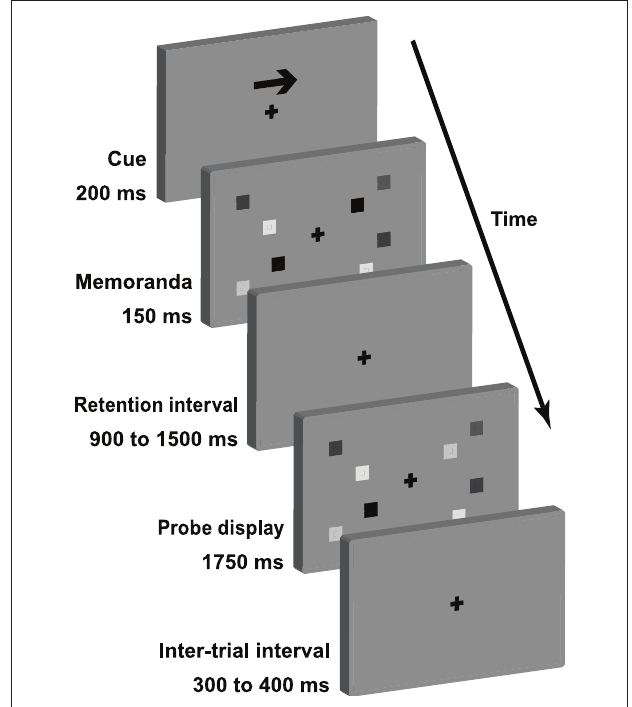
Figure 1 | The sequence of each trial of the change detection task. Actual memoranda varied in color rather than gray